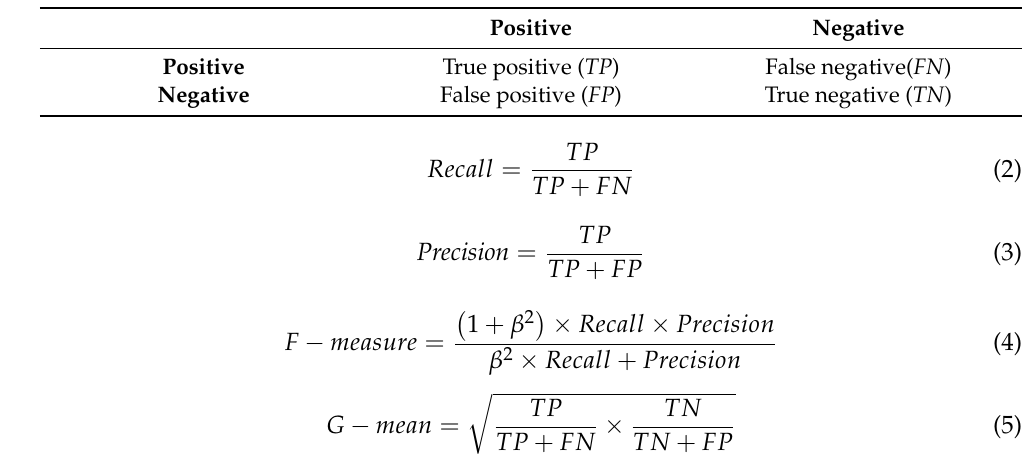
Table 1. Confusion